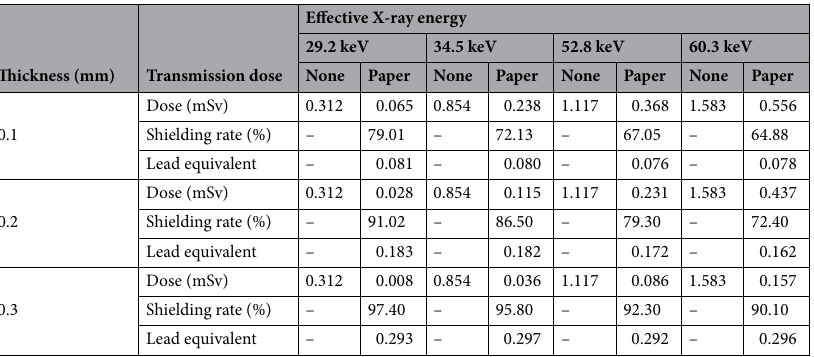
Table 5. Comparative evaluation of the shielding performance of the shielding paper with thickness.